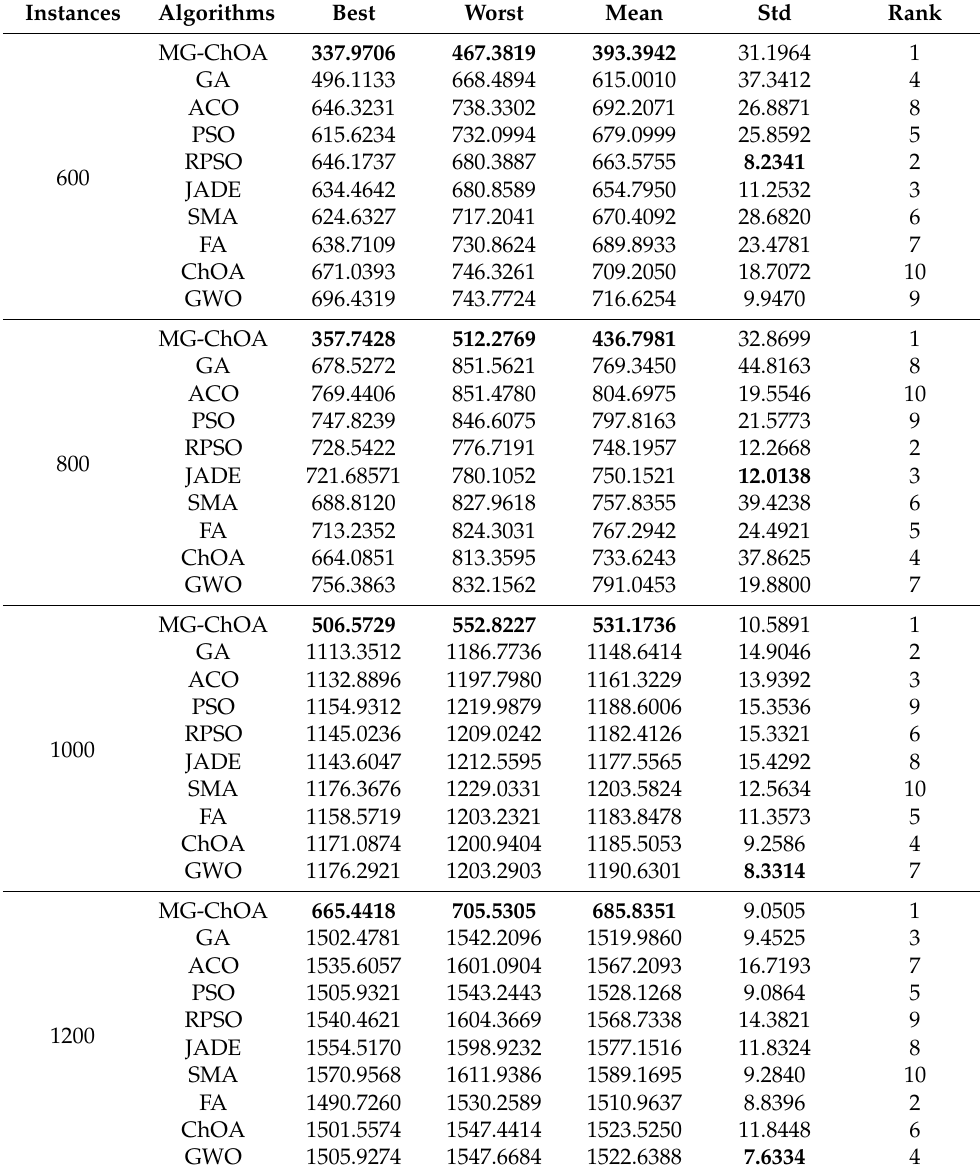
Table 6. Experimental results of the algorithms for instances of 600, 800, 1000, and